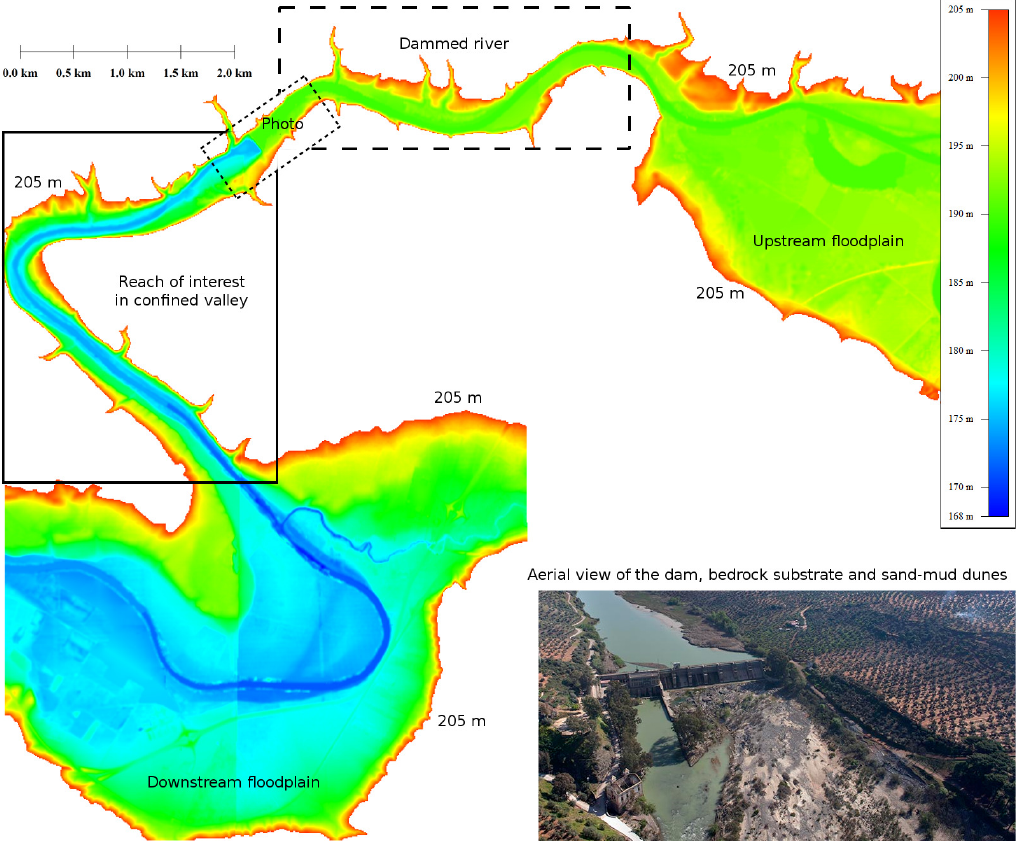
Figure 1. Digital elevation model of the study site showing the Guadalquivir River in the confined valley that connects the floodplains upstream and downstream of the Marmolejo dam (N 38 ◦ 3 (cid:48) 31 (cid:48)(cid:48) E 4 ◦ 11 (cid:48) 13 (cid:48)(cid:48) ). The drainage area of the Guadalquivir River Basin upstream of the dam is 19,546 km 2 . The characteristic dimensions of the dam are: height = 20 m, crest length = 230 m, spillway crest = 186.2 m, top of tainter gate = 191.73 m, outlet channel elevation = 175.35 m, reservoir capacity = 13 Hm 3 and design flood = 3450 m 3 · s − 1